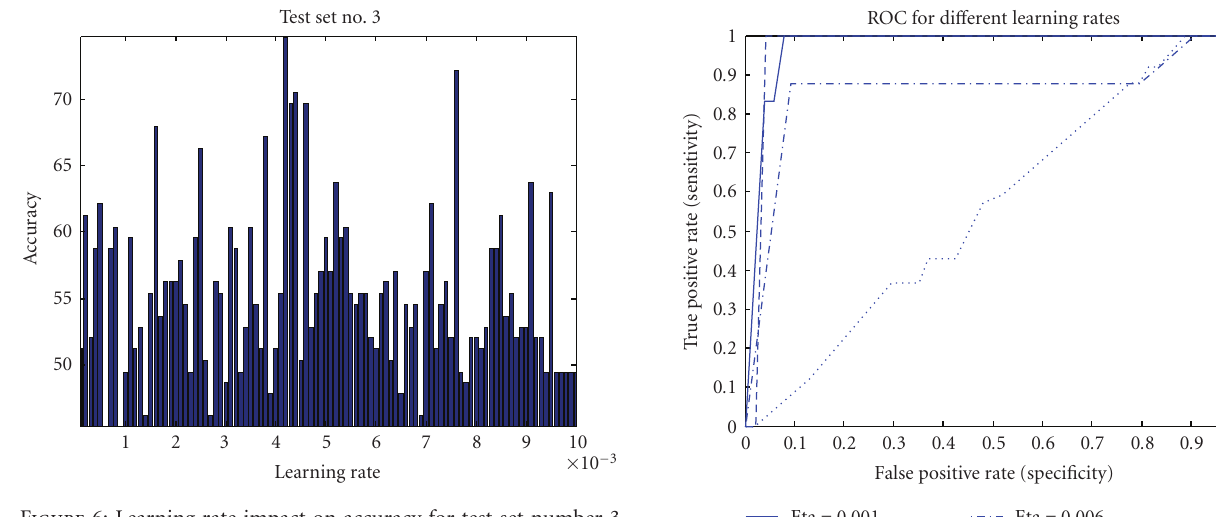
Figure 6: Learning rate impact on accuracy for test set number 3 (all other parameters were kept constant). Table 7: Threshold T impact on accuracy for test set number 1 while learning rate, mapping range, and PC are kept constants.